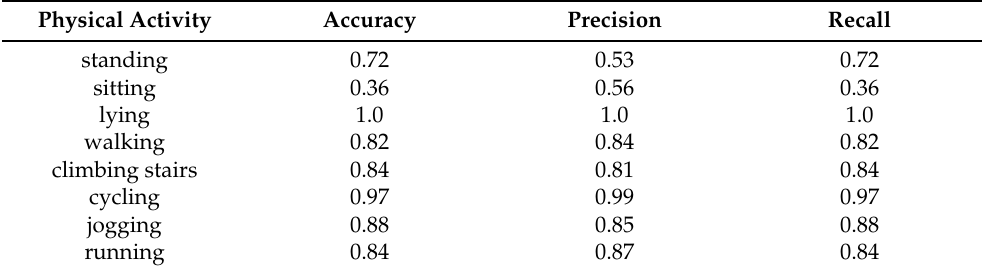
Table 2. Activities’ recognition rate for the RF classifier using the LOSO cross-validation method.